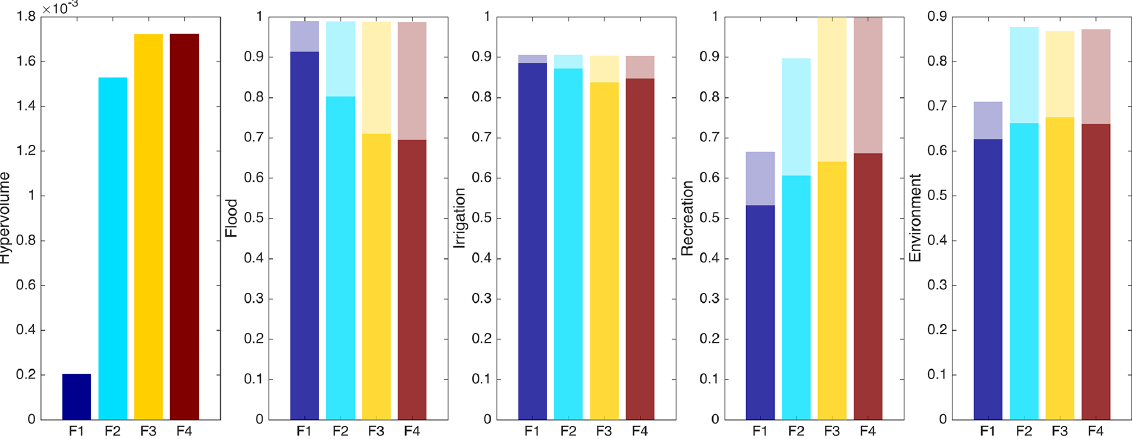
Figure 4. The hypervolume indicator and the best (transparent bar) and worst (solid bar) performance in each objective across the four formulations (F1–F4).